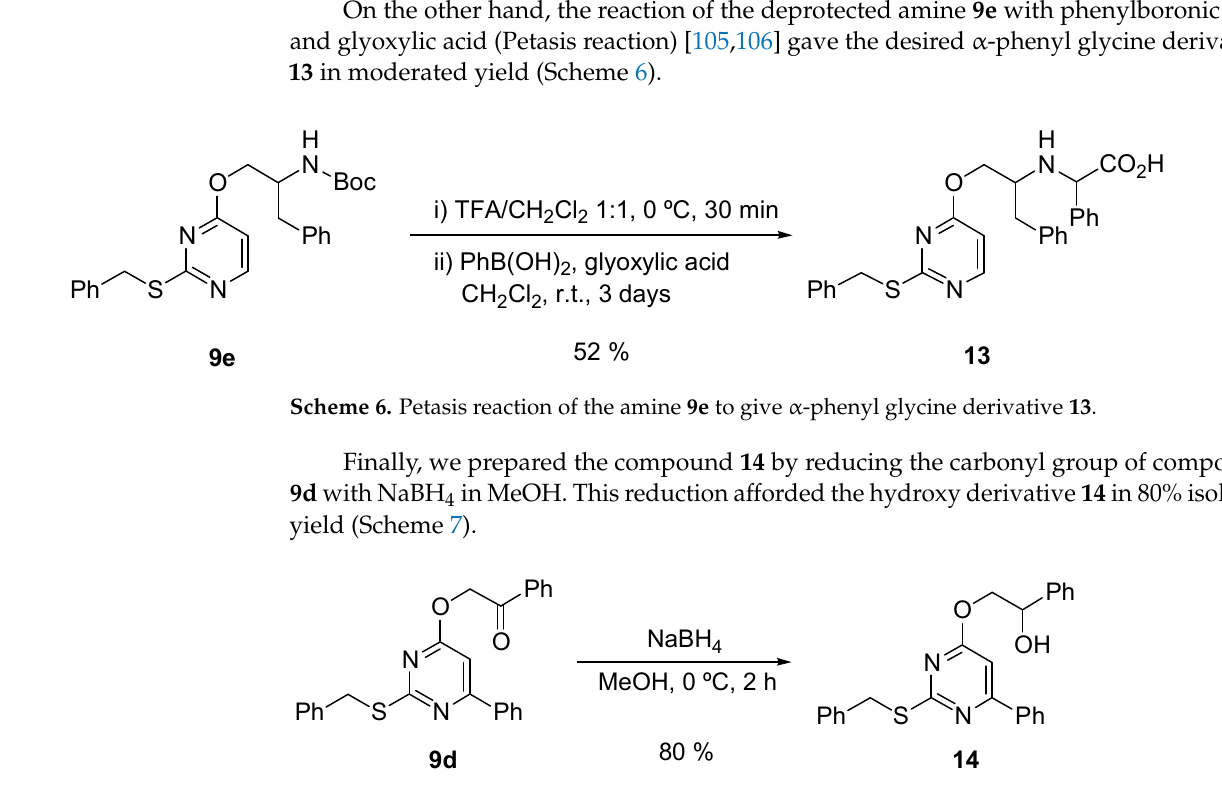
Scheme 7. Reduction of 9d to obtain the hydroxy derivative 14 .